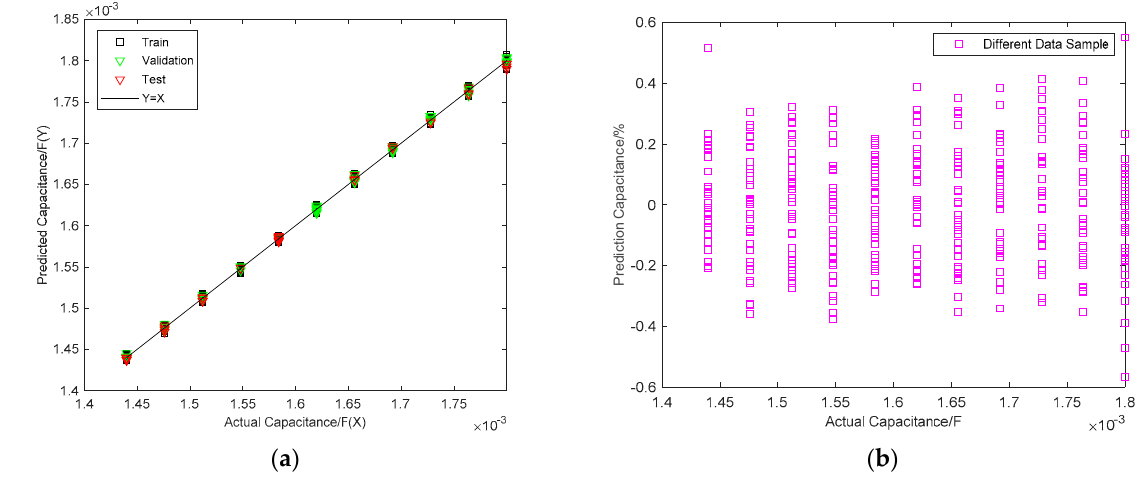
Figure 7. C Estimation results by ANN when N ESR = 10 ( a ) a best fitting showing train, test and validation results; ( b ) cross validation showing PEs for 10 fittings under 10 random data divisions.